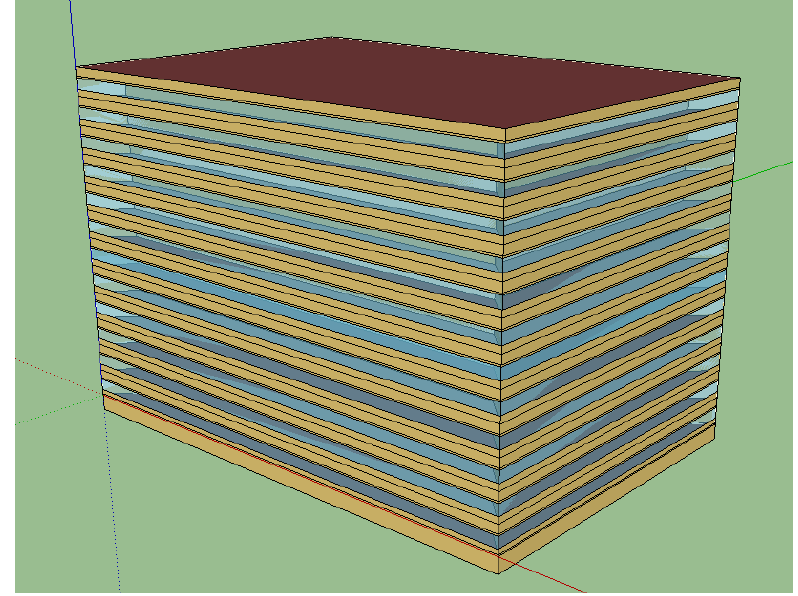
Figure 1. 3D view of the reference building: Large-scale office building.